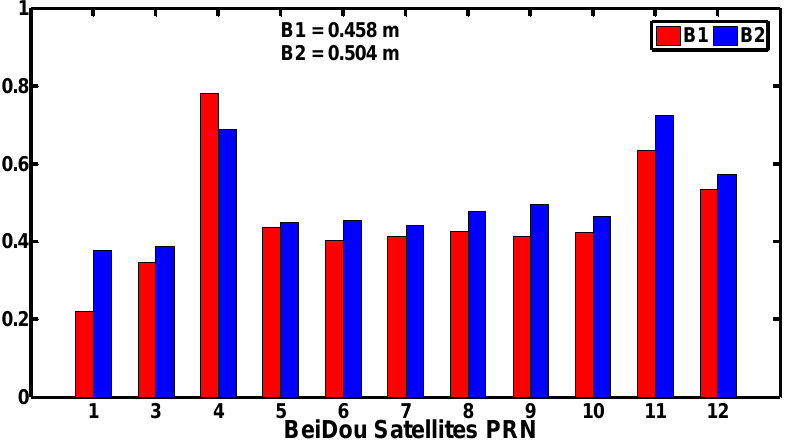
Figure 5. Standard deviations of MPCs of B1 and B2 codes of BeiDou satellites at CHDU station on September 24,